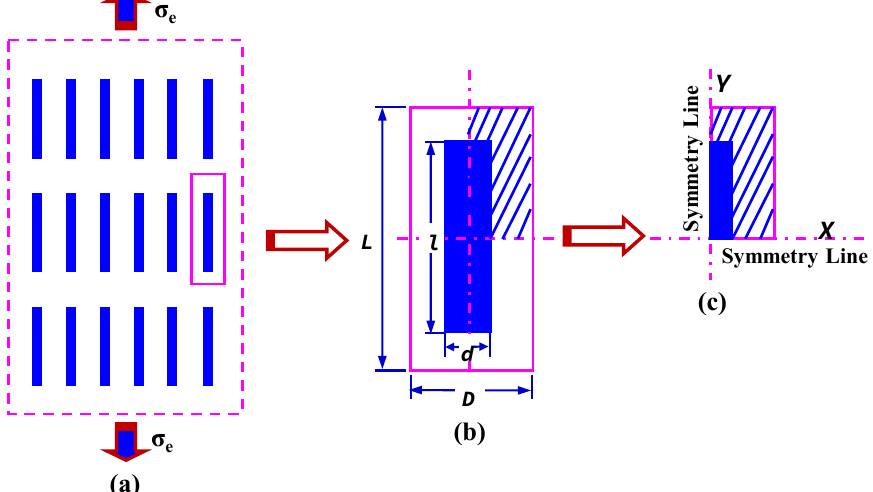
Figure 2. Representative volume element (RVE) of the stack model used for the present computational scaling analysis. ( a ) Idealized identical stacking clay platelets; ( b ) a typical RVE; and ( c ) a quarter RVE for efficient simulation.